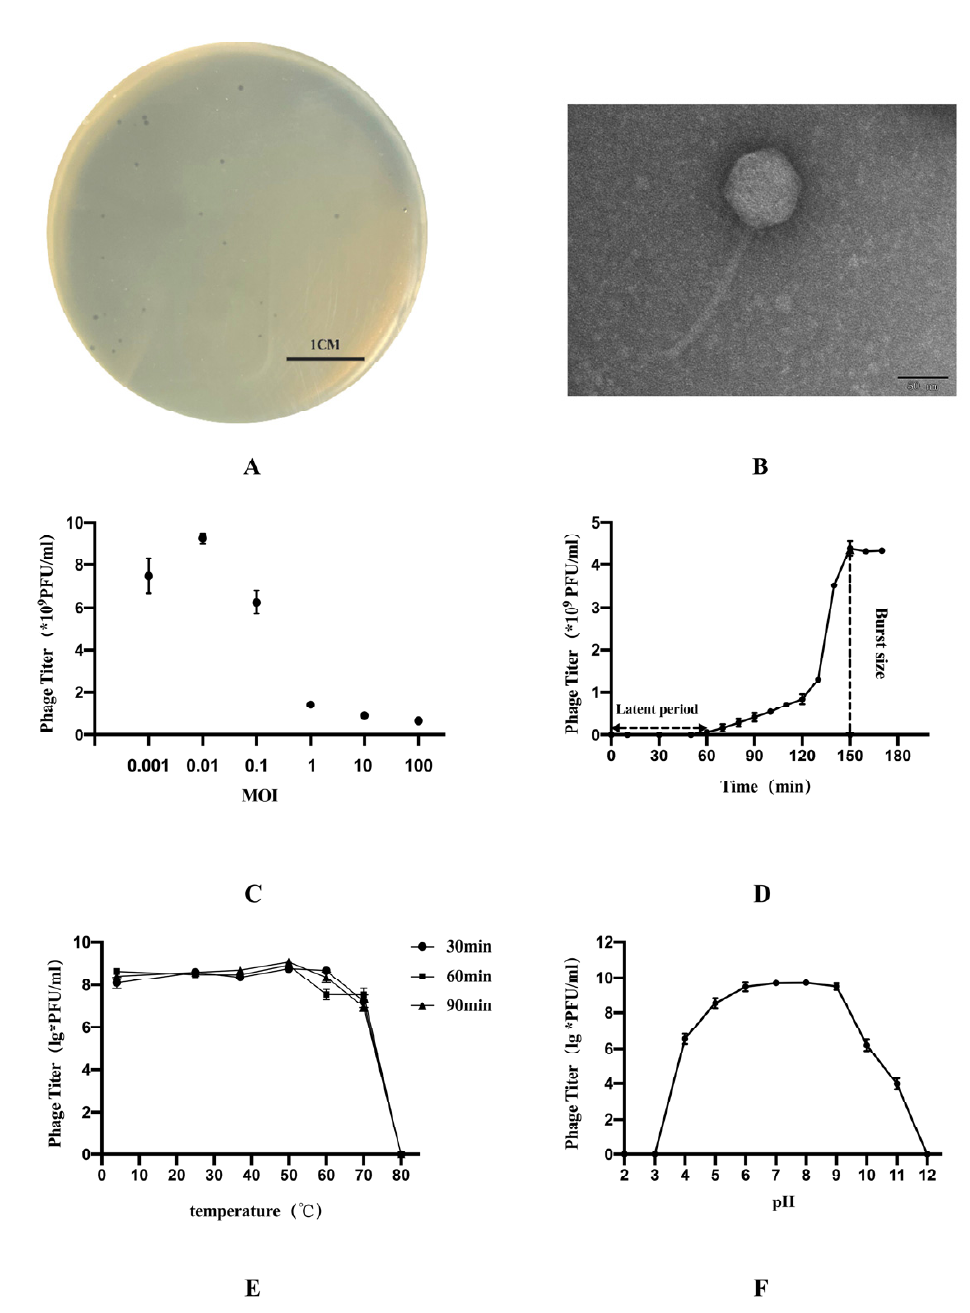
Figure 1. The morphology, biological characteristics of phage vB_EcoS_GN06: ( A ) Plaques of phage GN06. ( B ) Transmission electron microscopy (TEM) of phage GN06. ( C ) Determination of optimal multiplicity of infection (MOI) of phage GN06. ( D ) One-step growth curve of phage GN06. ( E ) Thermal stability of GN06. ( F ) Stability of phage GN06 in different pH values. The highest titer of phage GN06 was released under the multiplicity of infection